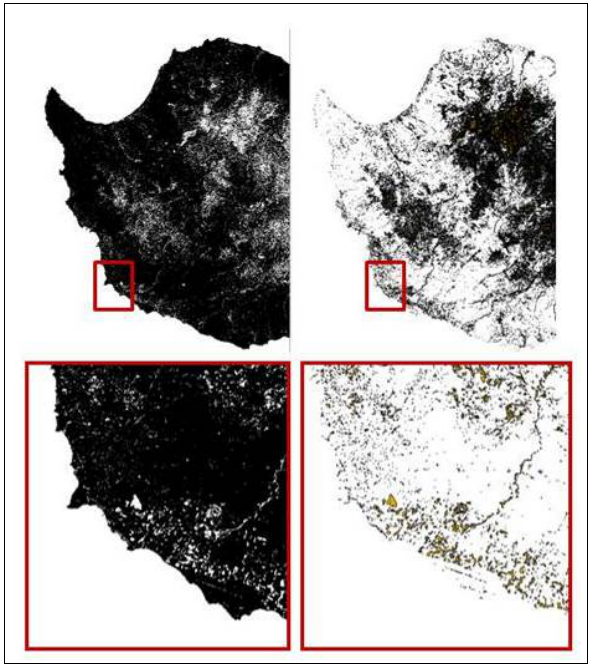
Figure 3. Normalization of significant areas for threshold 0.2: all changes below this threshold were given the value of 0, all values above 0.2 were given the value of 1. Above left raster image and above right vector values obtained through vectorization procedure; respective details below. Figure 7. Difference in C-factor over nearly last 30years observed false colour: more significant changes possibly impacting the erosion of the soil in Paphos District are highlighted in red and dark red